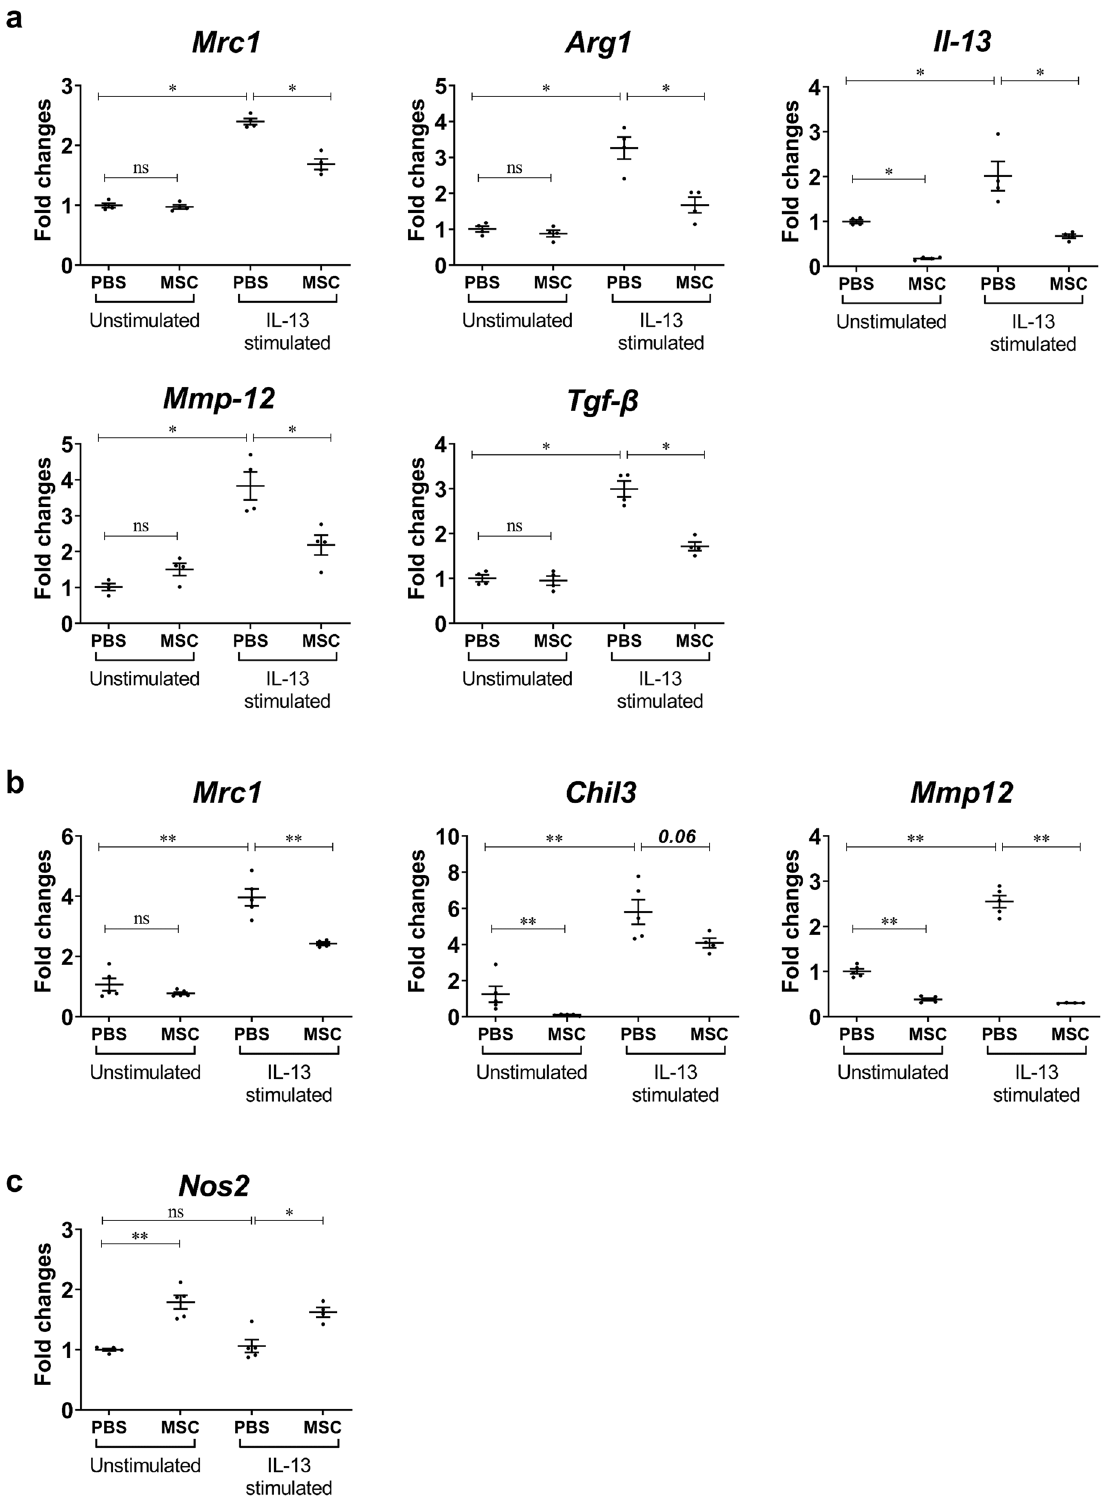
Figure 5. Effects of Liproxstatin-1-primed hUC-MSCs on murine macrophages. ( a – c ) Murine macrophages were co-cultured with hUC-MSCs in a trans-well system and ex vivo alveolar macrophages ( a ) and bone marrow-derived macrophages ( b , c ) were subjected to RT-qPCR analysis for mRNA evaluation of markers of polarized macrophages. Gapdh and Hprt1 were used as internal controls. Values in all the panels are mean ± SEM. All results are representative of at least three independent experiments. *p < 0.05, **p < 0.01, ns stands for not significantly different (by Kruskal Wallis test using GraphPad Prism 7, https:// www. graph pad. com). Il-13 interleukin 13, Mmp-12 matrix metallopeptidase 12, Tgf-β transforming growth factor beta